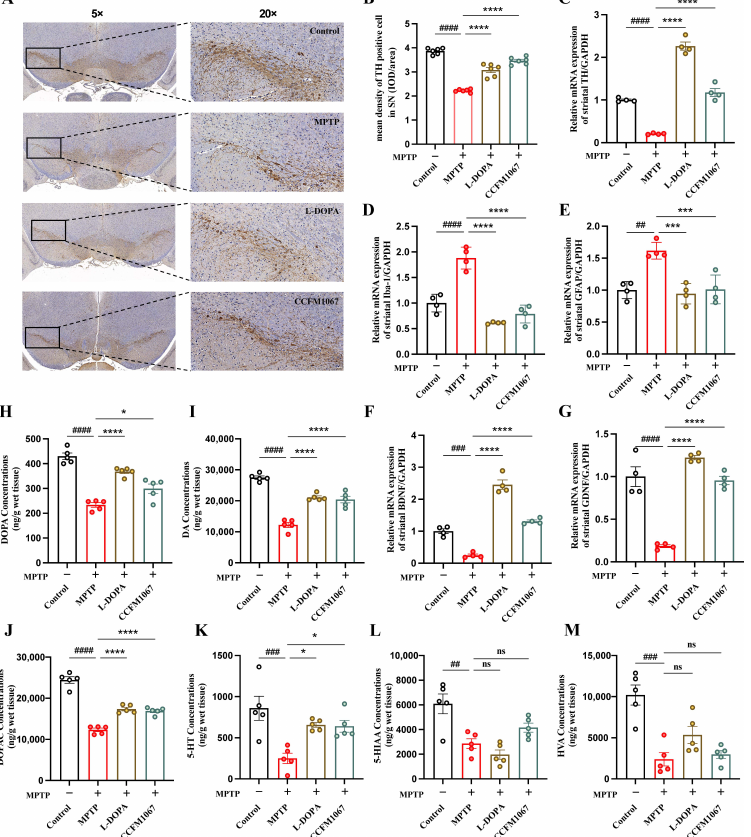
Figure 2. B. breve CCFM1067 alleviated MPTP-induced neuropathologic changes and glial activa-